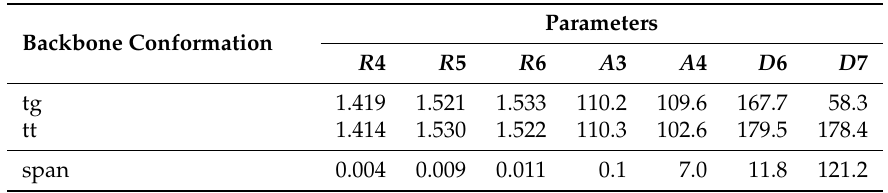
Table 4. The optimized conformation type and geometrical parameters of the stable Ch + conformers ( R (in Å); A and D (in